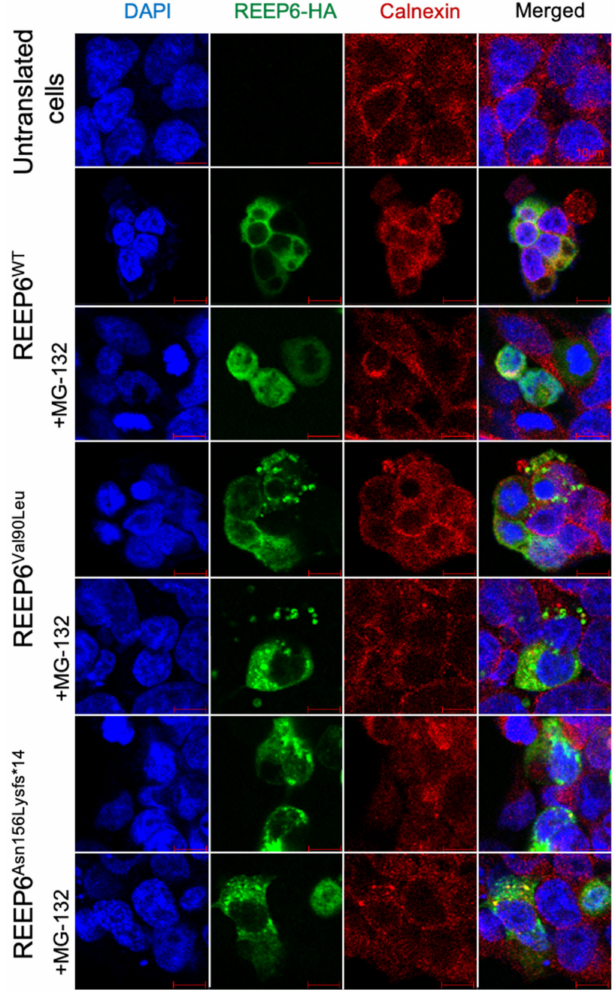
Figure 6. The expression of wild type, p.Val90Leu and p.Asn156Lysfs*14 REEP6 proteins in HEK293T cells. Cells were treated with MG132 for 2 hours before fixation. REEP6 were labeled with anti-HA (green). ER was labeled with anti-calnexin (red). DAPI (blue) was used to stain